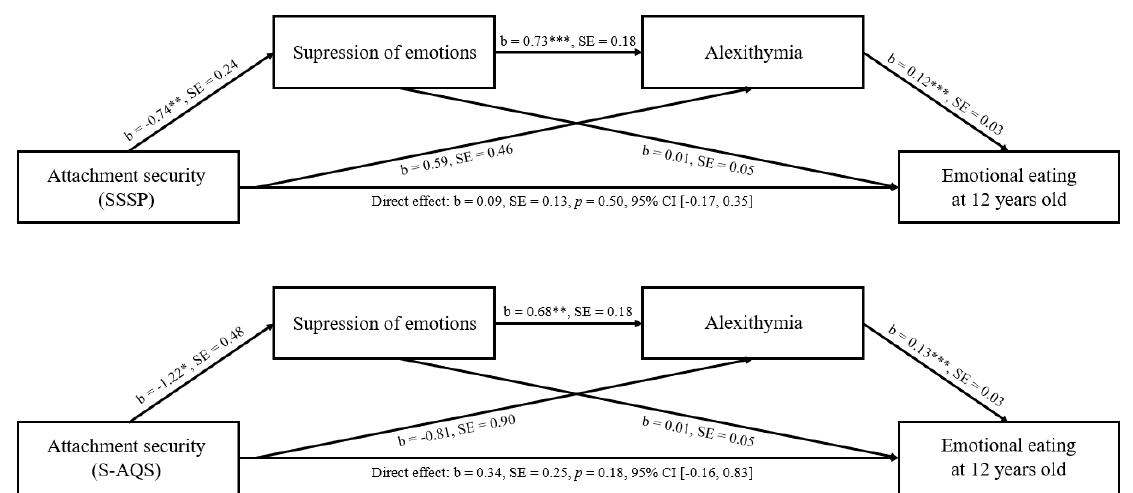
Figure 2. Suppression of emotions and alexithymia as mediators between attachment security and emotional eating at the age of 12 years old. Notes. * p < 0.05; ** p < 0.01; *** p < 0.001. b = unstandardized regression coefficients; SE = standard errors; SSSP = shortened strange situation procedure, S-AQS = shortened attachment Q-set.